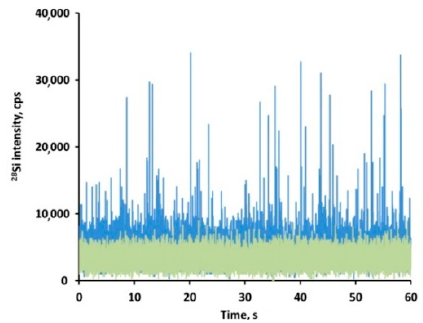
Figure 5. Time scan of control (green) and NM-203 treated (blue) liver samples in spICP-MS.